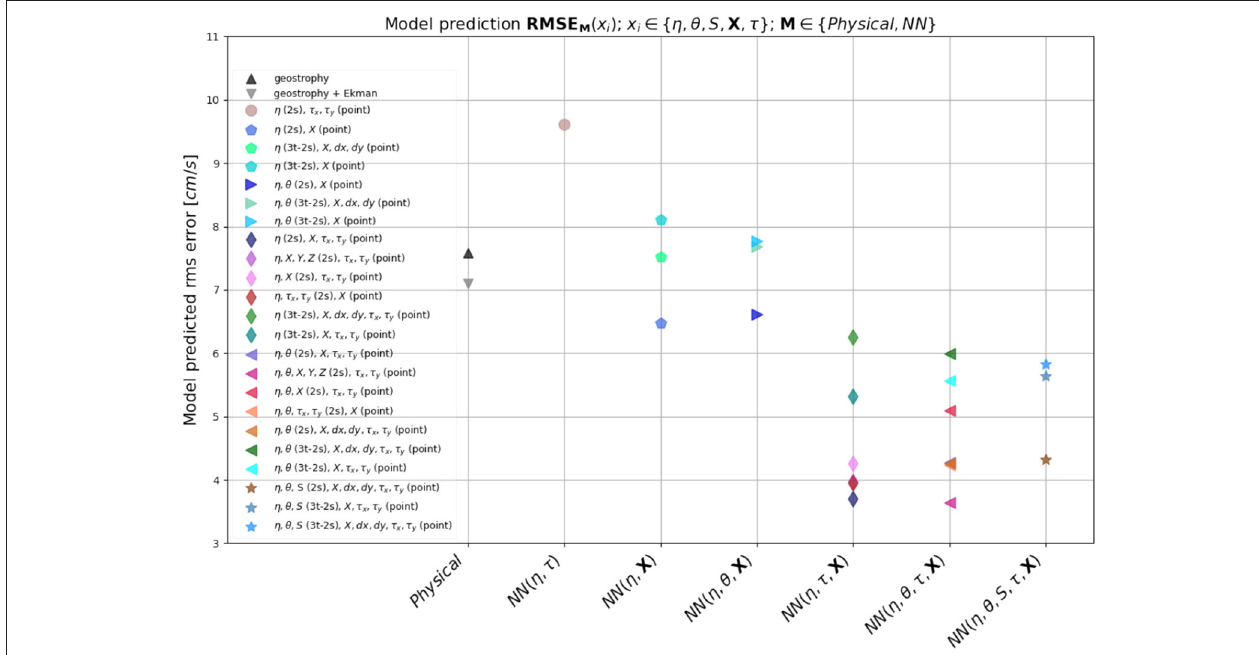
FIGURE 8 | Figure comparing the rms error of the different model predictions along with the rms error for the physical models as a function of features.